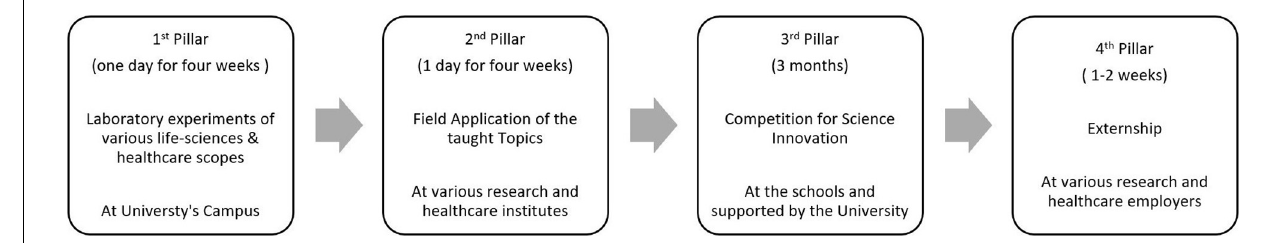
FIGURE 1 | Empower Generations (EG) training